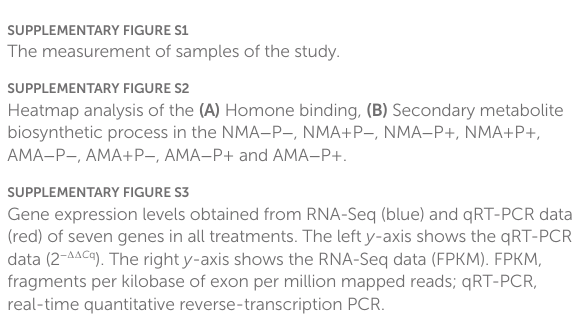
SUPPLEMENTARY FIGURE S1 The measurement of samples of the study. SUPPLEMENTARY FIGURE S2 Heatmap analysis of the (A) Homone binding, (B) Secondary metabolite